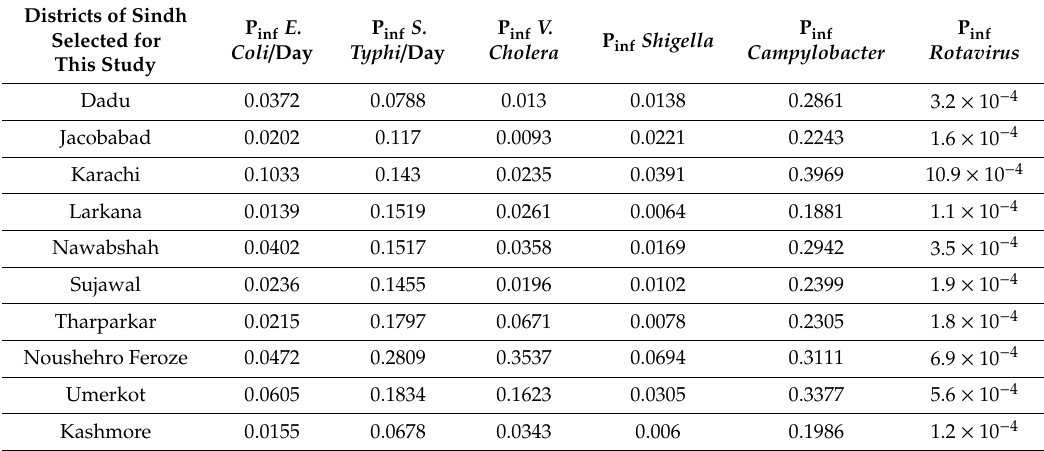
Table A1. Probability of infection per day